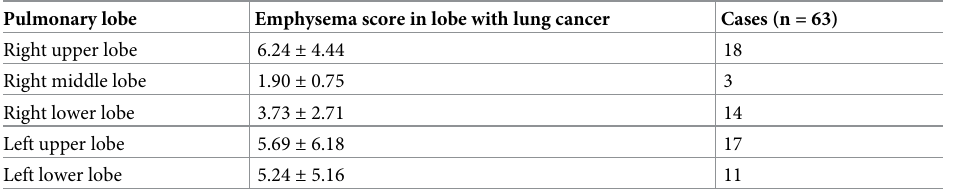
Table 2. Relationship between location of lung cancer and lobar emphysema ratio in the high LER group.